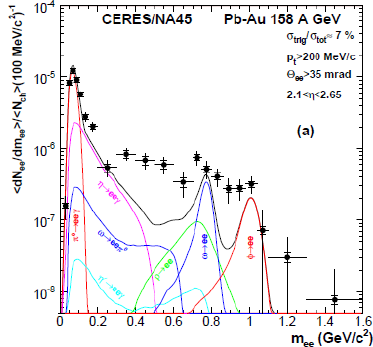
Figure 2. Invariant-mass spectrum of e + e − -pairs compared to the expectation from the hadron decay cocktail